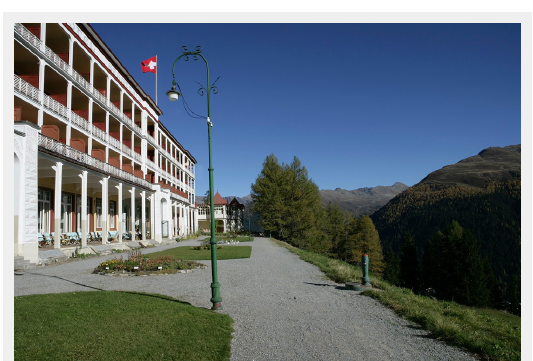
History of drug discovery and development of treatment regimens for tuberculosis. Compounds that are in the early-stage of development, but for which there are no published human proof-of- concept data, are not shown. Arrow with dashed line represents a possible future regimen. Red dots represent when the drugs were first reported. (From [51]: Ma Z, Lienhardt C, McIlleron H, Nunn AJ, Wang X. Global tuberculosis drug development pipeline: the need and the reality. Lancet. 2010;375(9731):2100–9. Copyright 2012, with permission from Elsevier, Oxford, UK.)